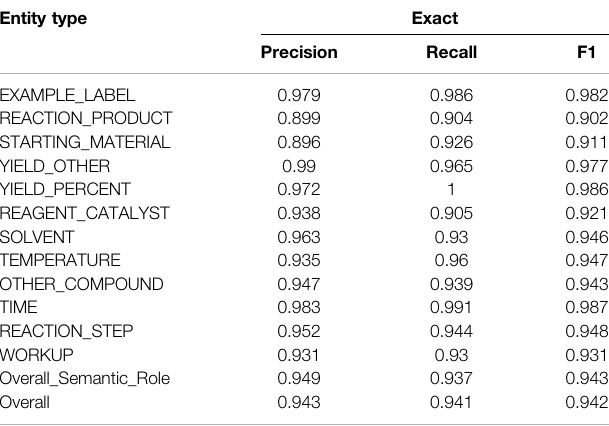
TABLE 4 | Performances on NER of semantic roles and event triggers on the development set are reported. The fi ne-tuning method was used in the experiment. Event triggers are italic.